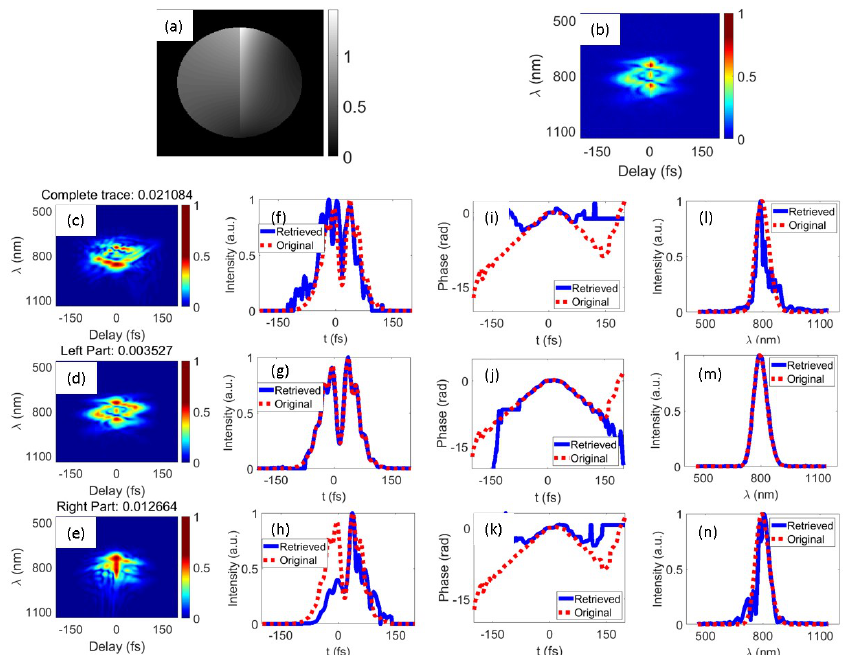
Figure 3. Numerical reconstruction from a partially polluted THG − FROG trace of a Gaussian spec- trum pulse. ( a ) simulated poor spatial distribution, ( b ) polluted FROG trace, ( c – e ) reconstructed traces, ( f – h ) amplitude of reconstructed pulses, ( i – k ) phase of reconstructed pulses, and ( l – n ) spectral intensity distributions of the reconstructed pulses.